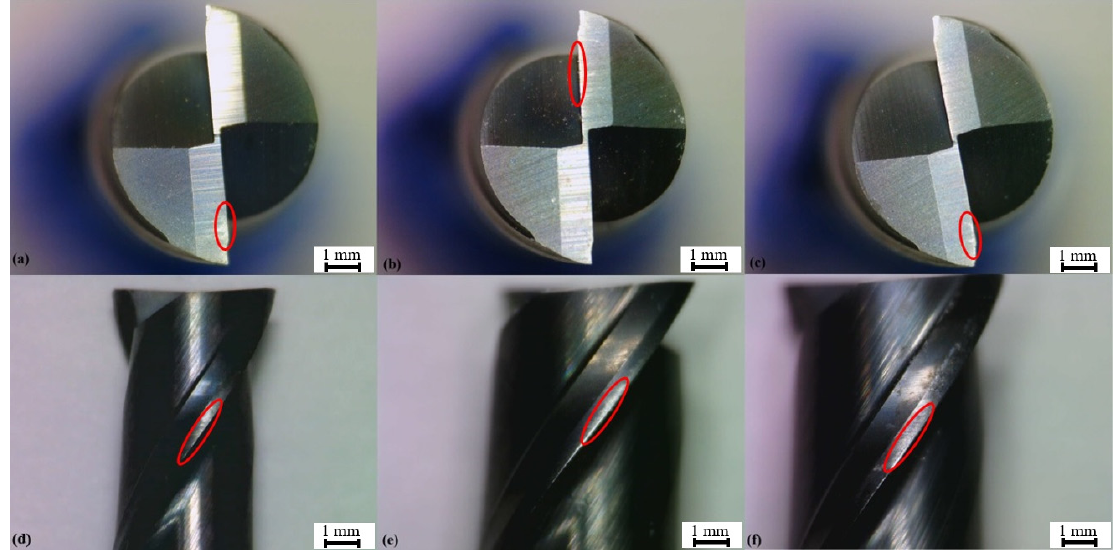
Figure 6. Tool Wear Examples—( a ) 0 degrees, ( b ) 35 degrees, ( c ) 90 degrees top view sample tool wear. ( d ) Zero degrees, ( e ) 35 degrees, ( f ) 90 degrees side view sample tool wear .